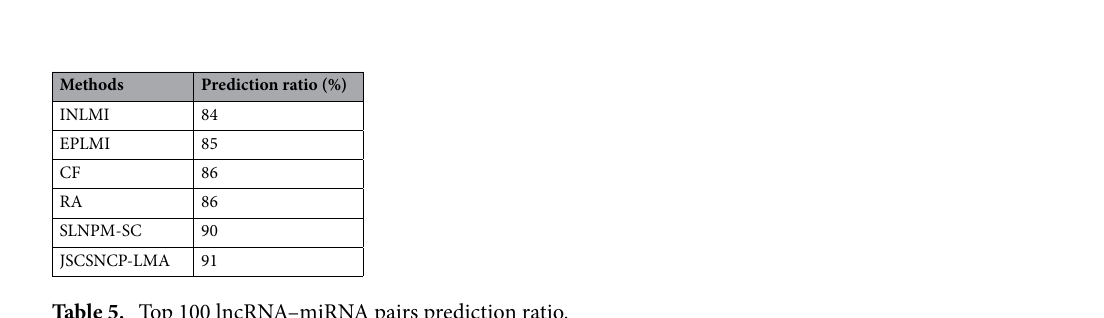
Table 4. Top 10 miRNAs-related candidate lncRNAs.